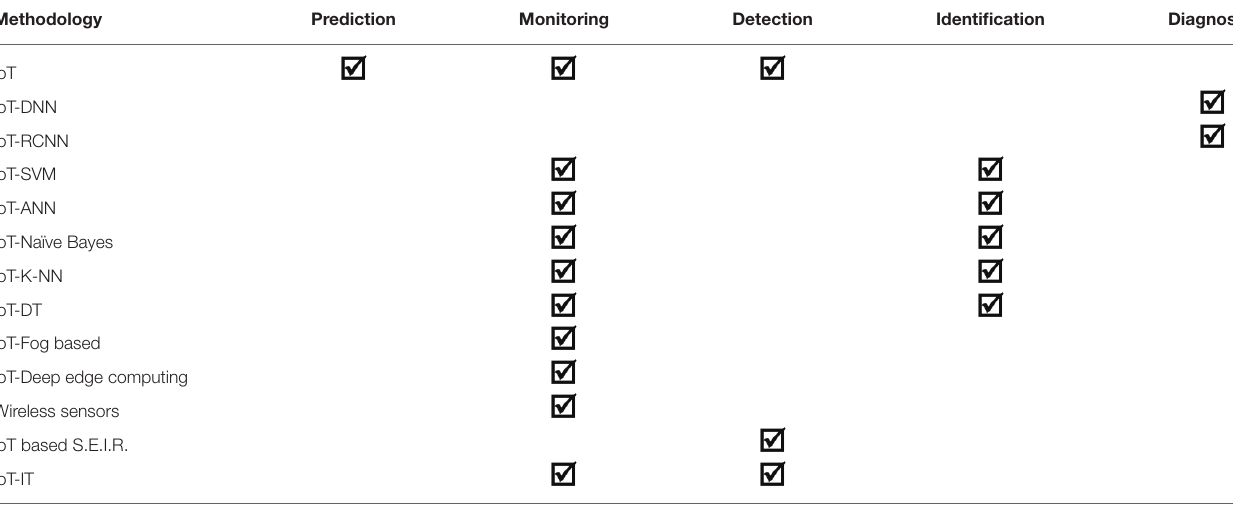
TABLE 3 | The main contribution of the study for the application of IoT based